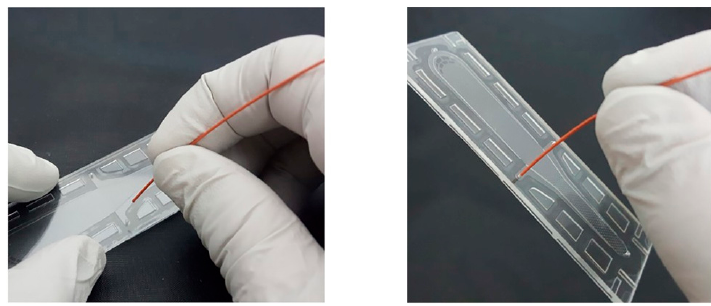
Figure 7. Connection procedure by hands. It takes less than 2 seconds.